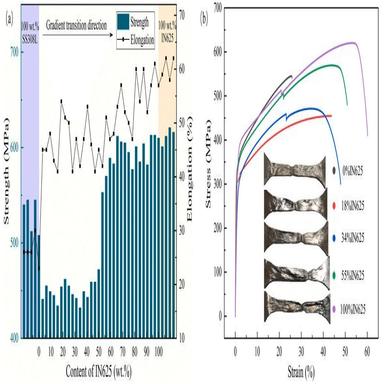
Tensile properties in the building direction of the FGM. (a) Tensile test results, (b) typical engineering stress-strain curves and the fracture samples.